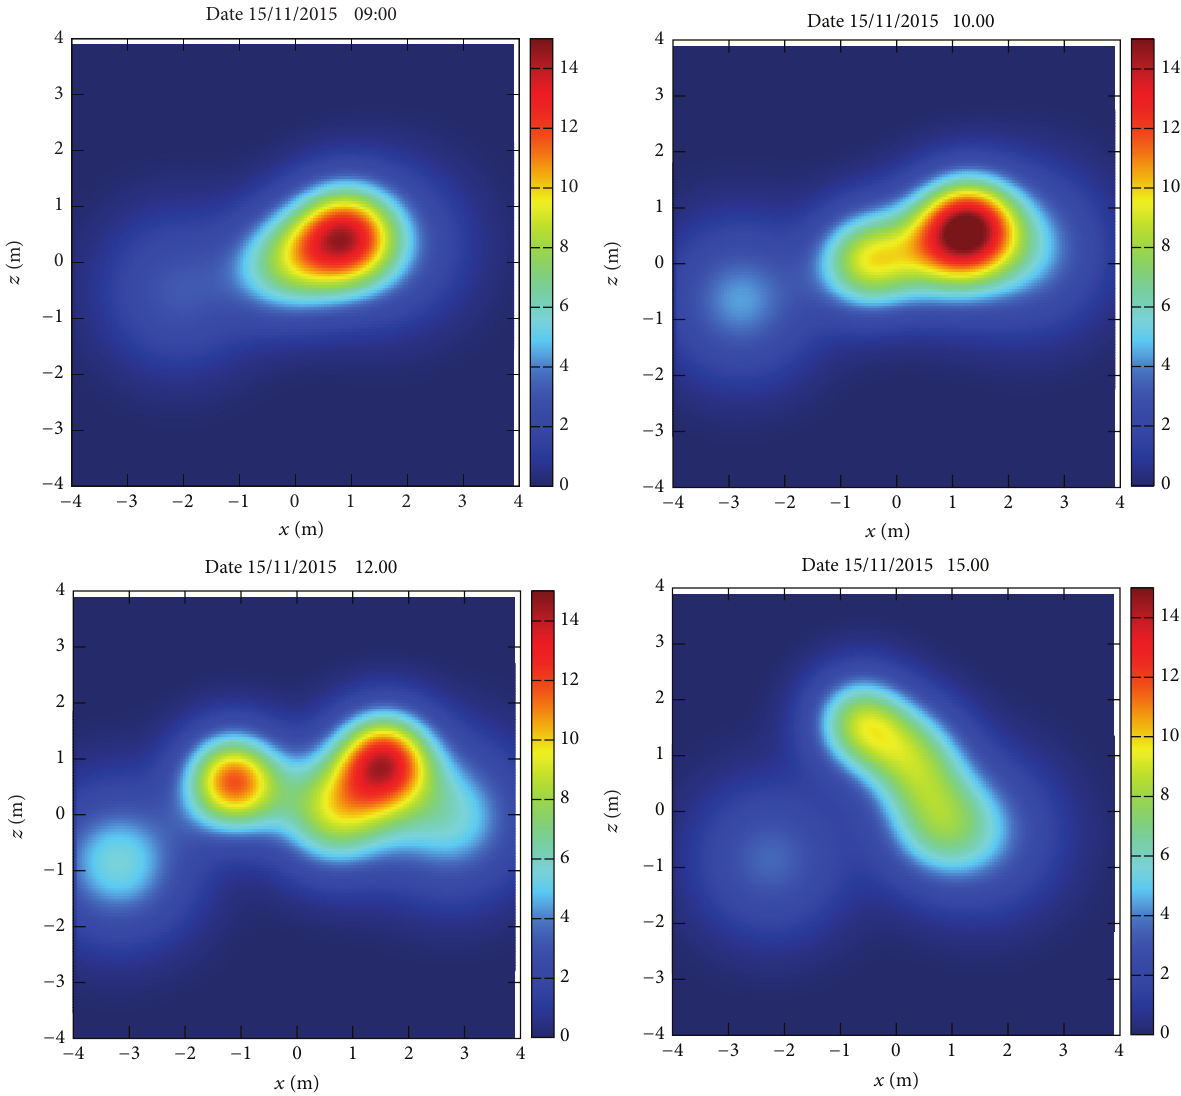
Figure 8: Flux distributions on the receiver for 5 heliostats in a case with drift, for the indicated hours and date, at local time of Hermosillo, Sonora, Mexico. The color scale expresses irradiance in units of W/m 2 . Table 1: Comparative of peak fluxes and average fluxes of analytical method using Matlab and Monte Carlo method by using SolTrace. Heliostat 𝑥 ,